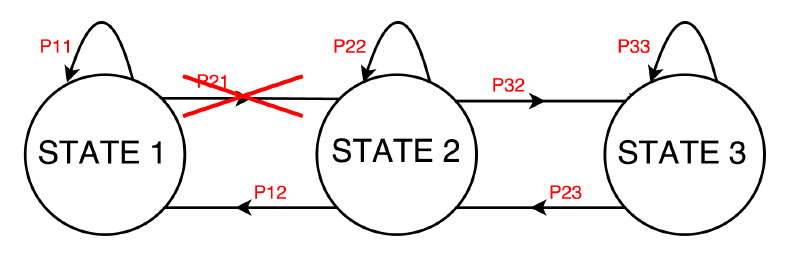
Figure 4. Example of a state machine for a washing machine derived by taking into account user presence